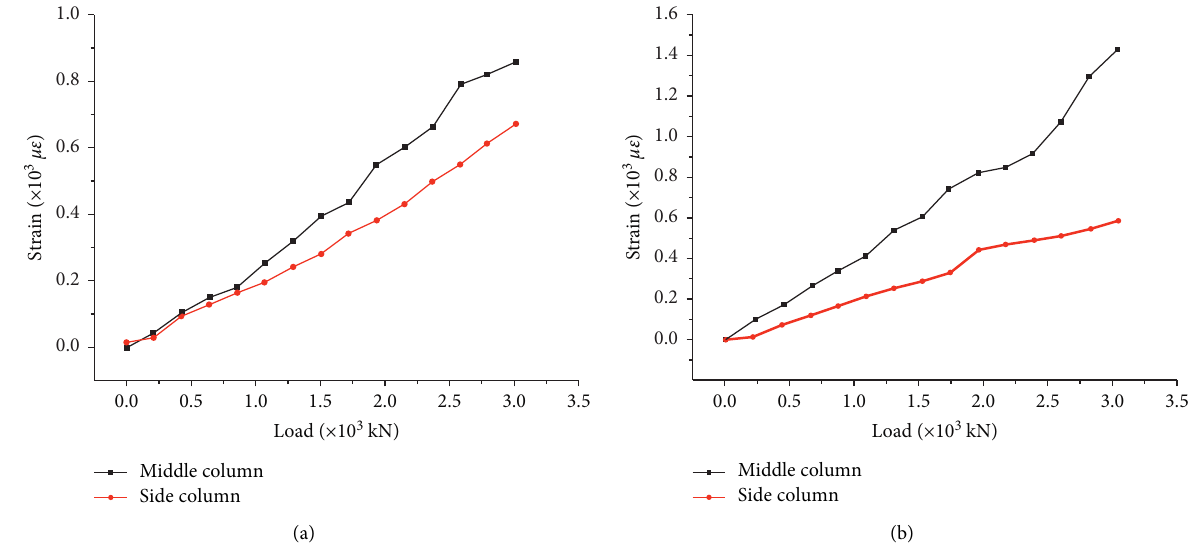
Figure 13: The strain-load curves: (a) steel reinforcements in the inner wall; (b) concrete at the top of the columns.